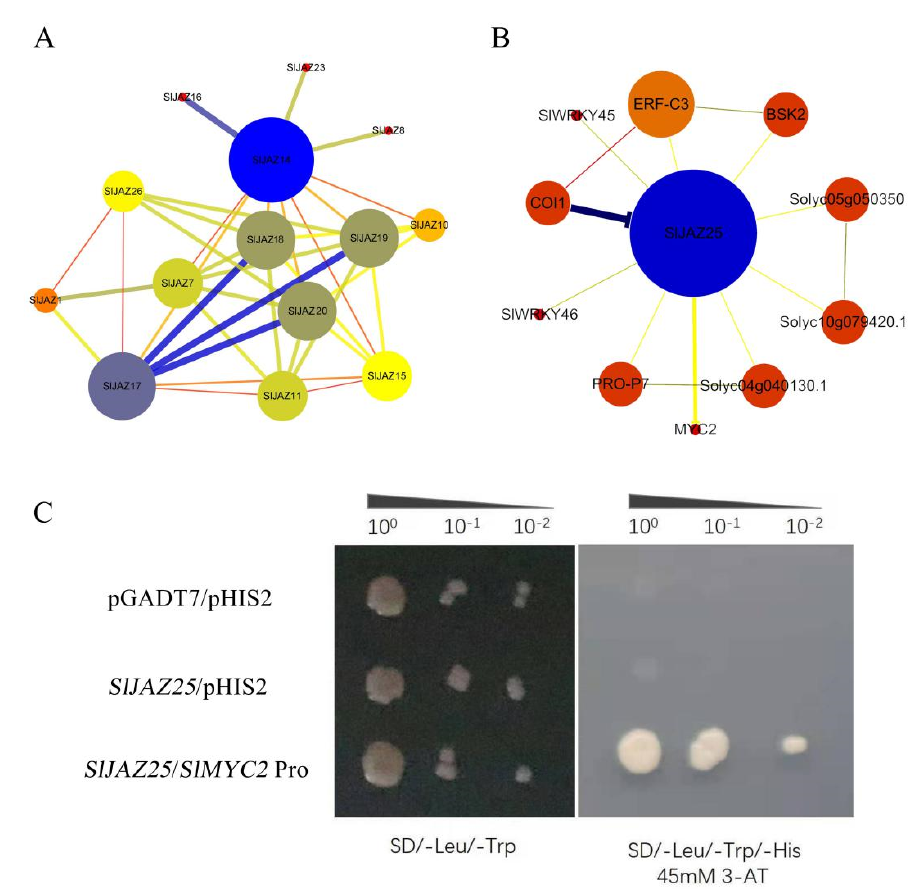
Figure 12. Co-expression network of SlJAZ s and the regulatory network relationship of SlJAZ25 in tomato. SlJAZ25 binds to the SlMYC2 promoter. ( A ) Co-expression network of SlJAZ s. ( B ) Regulatory network relationships of SlJAZ25 in